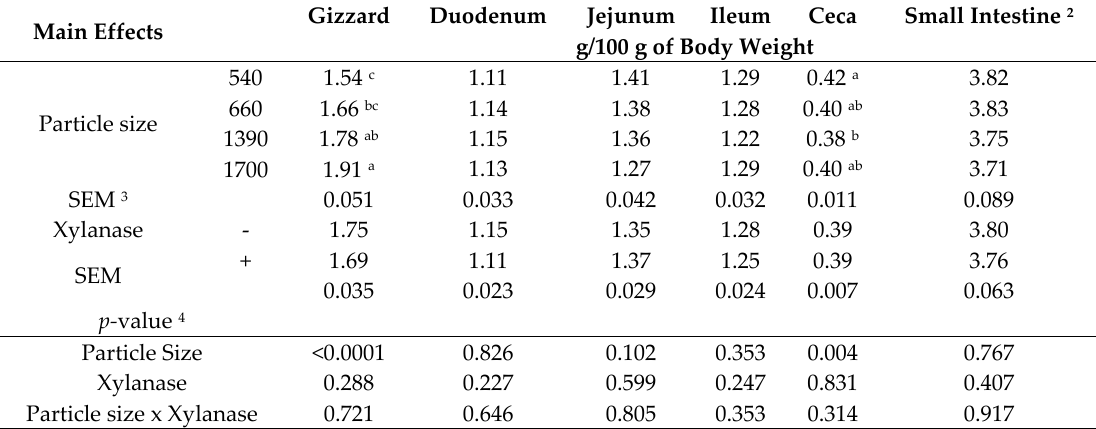
Table 8. Effects of particle size and xylanase inclusion on 21-day relative organs weight 1 .